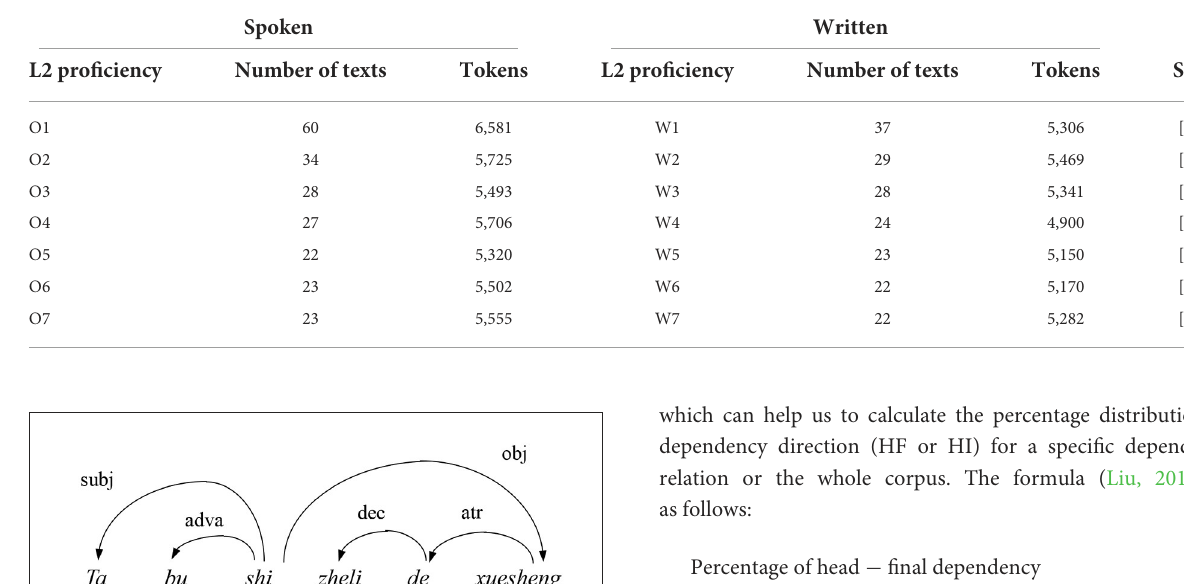
TABLE 1 A profile of source material.